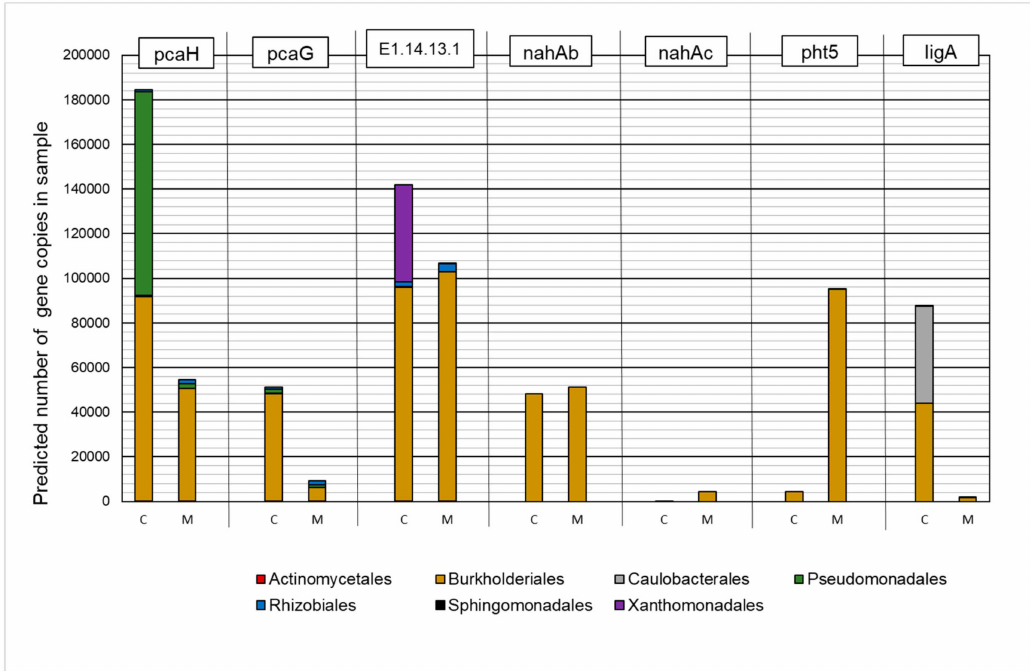
Figure 5. The contribution of the predicted number of gene copies involved in polycyclic aromatic hydrocarbon biodegradation to bacteria orders in the control sample (C) and in a sample containing 150 mg · L − 1 of heavy metals